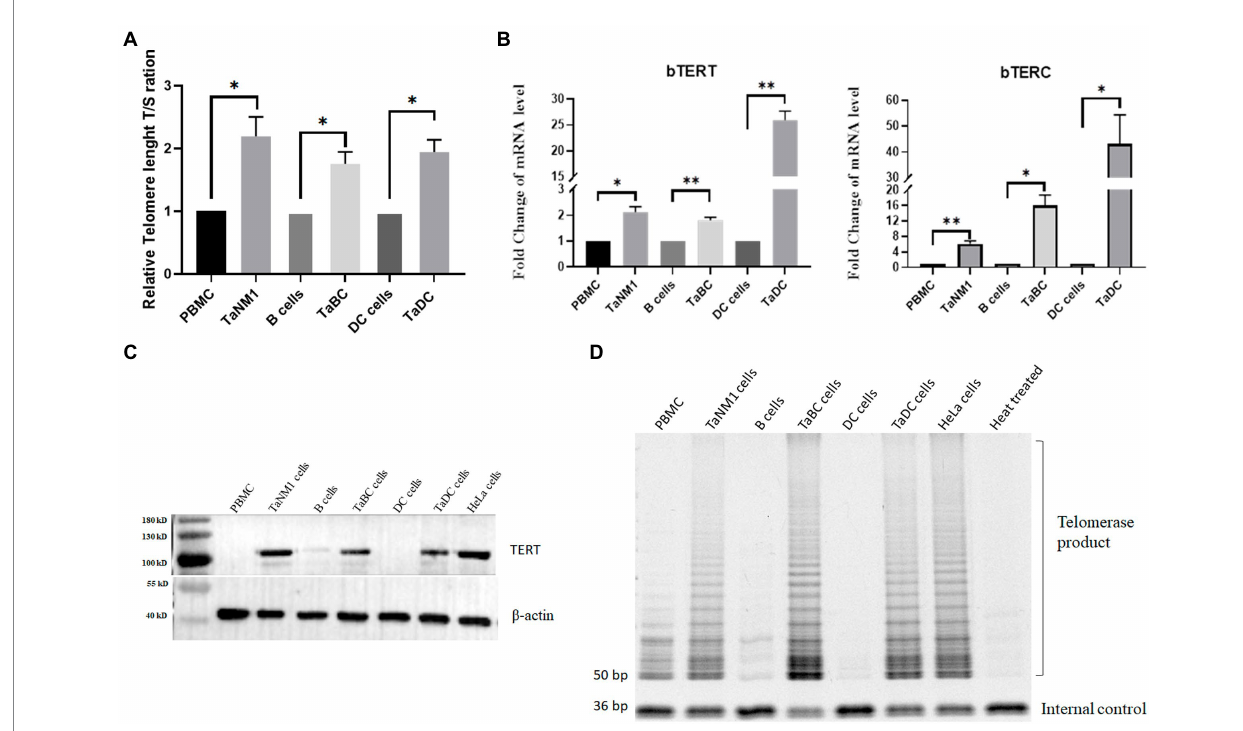
FIGURE 1 Theileria annulata infection increased telomere length and telomerase activity. (A) The relative telomere length is significantly increased after T. annulata infection in three types of cell lines. Normal PBMCs, B cells, and DCs cells were used as control group. (B) Transcriptional analysis of the bTERT and bTERC genes in normal cells and T. annulata -infected PBMCs, B cells DCs. (C) Western blot analysis of the protein expression level of bTERT in the cells before and after T. annulata infection. HeLa cell lysates were taken as the TERT-positive group. (D) TRAP assay analysis of the telomerase activity of normal cells (PBMCs, B cells, and DCs) and T. annulata -infected cells (TaNM1, TaBC, and TaDC). HeLa cell lysates were taken as telomerase- positive control. Heat-treated (100 ° C for 10 min) TaNM1 cell lysates were taken as telomerase-negative control. The Student’s T test was used for statistical analysis from the results of three independent experiments. The error bars denote the standard error. * p < 0.05, ** p <